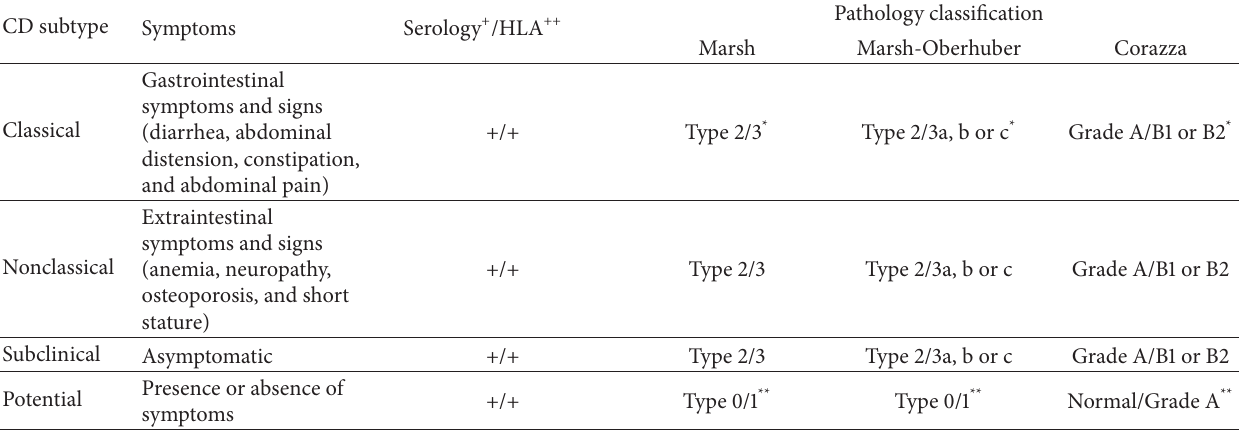
Table 1: Classification of CD subtypes.